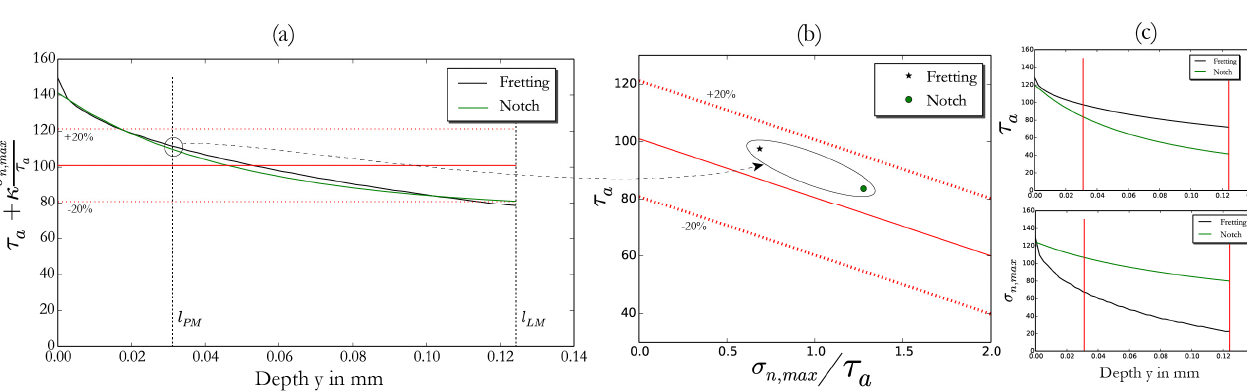
 , against the normalized maximum a  and   against distance for fretting and notch / a , n max a